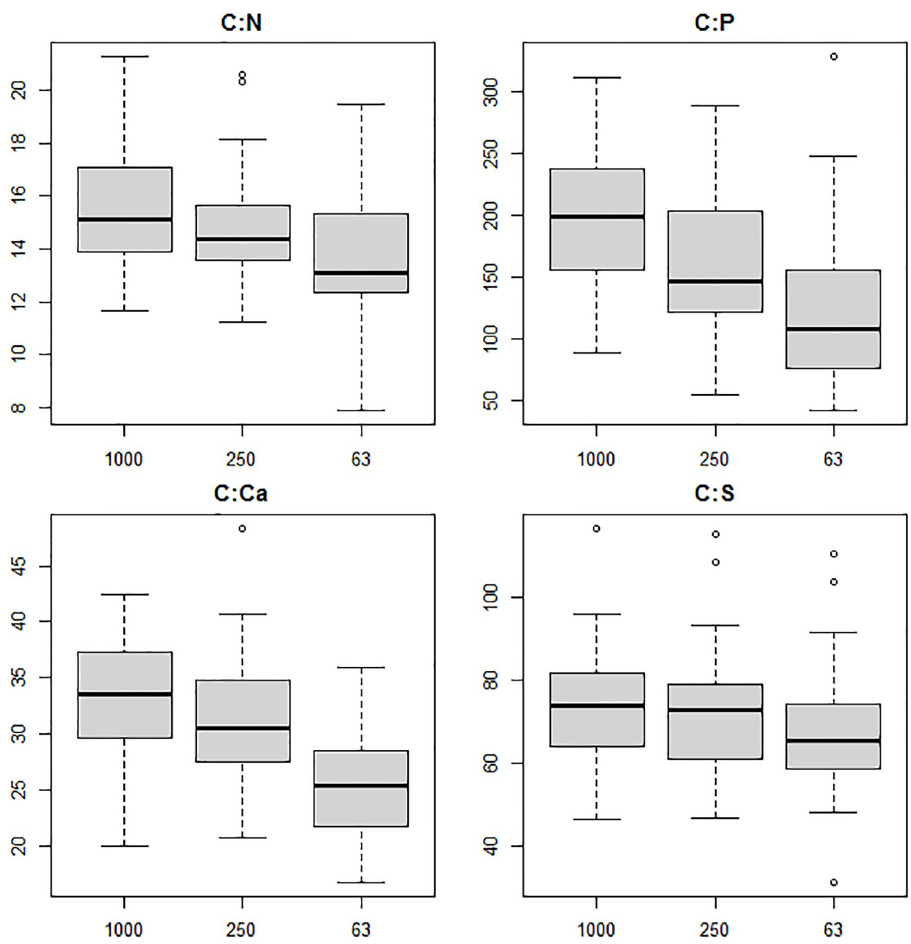
Fig 3. C:N, C:P, C:Ca and C:S ratios in the constituent size fractions of detritus. Median, 1st and 3rd quartile, extremes and outliers are indicated.